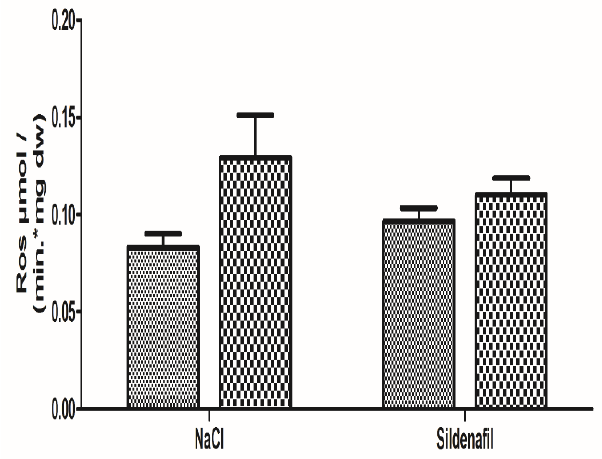
Figure 4. Reactive Oxygen species (ROS) production in ischemic and non-ischemic gastrocnemius in mice treated (n = 8) or not (n = 8) with sildenafil. ROS level was obtained using electron paramagnetic resonance. For both NaCl and Sildenafil groups: left column, non-ischemic contralateral limb. Right column: Ischemic limb. Results are expressed as means ± SEM. p = 0.08 in the NaCl group.